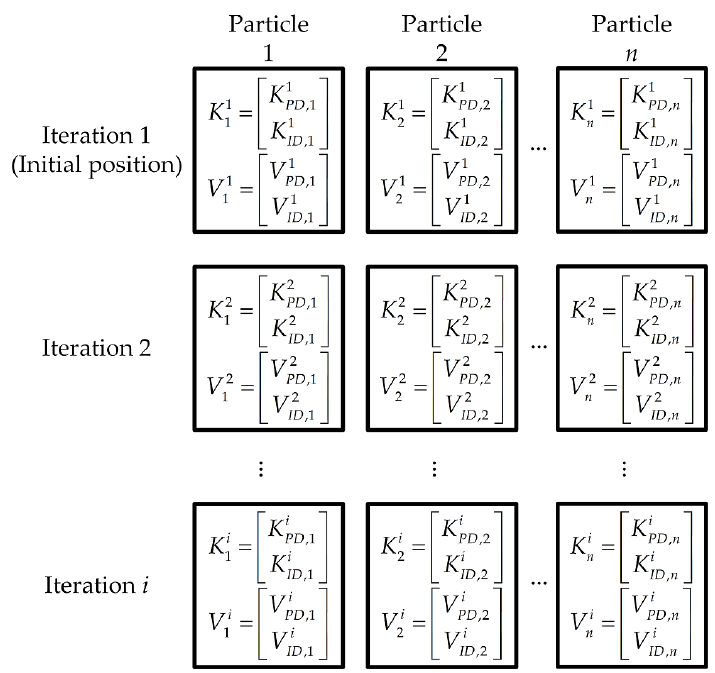
Figure 8. Schematic diagram of particle positions and velocities in every